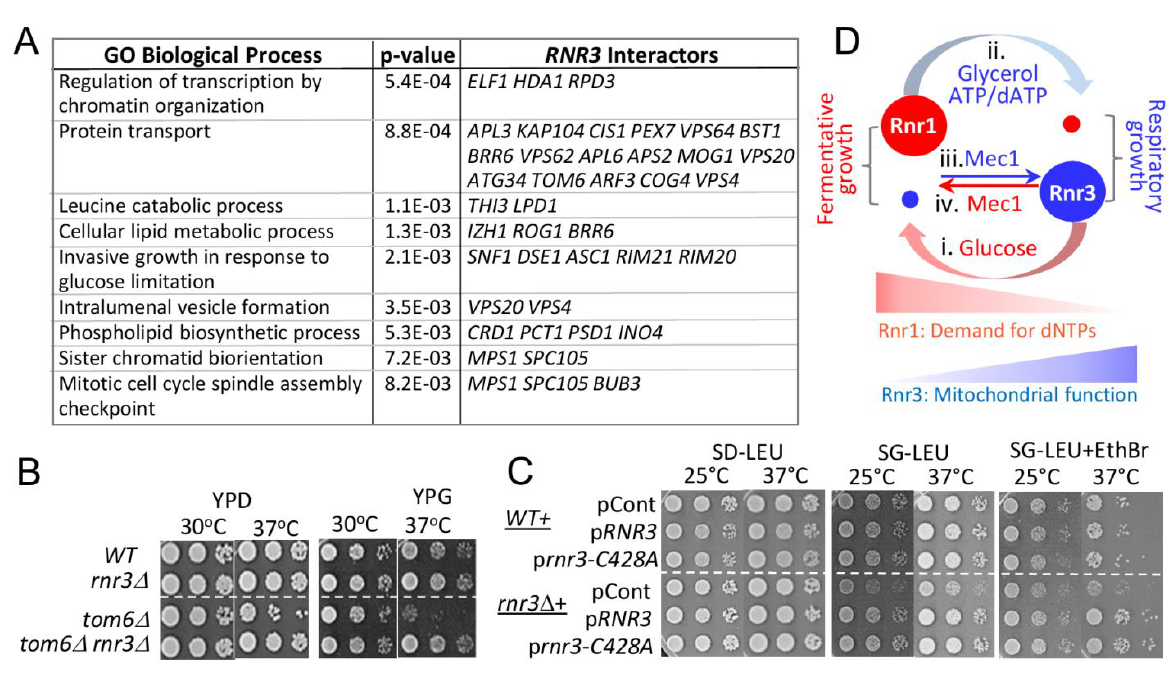
via a mechanism yet to be